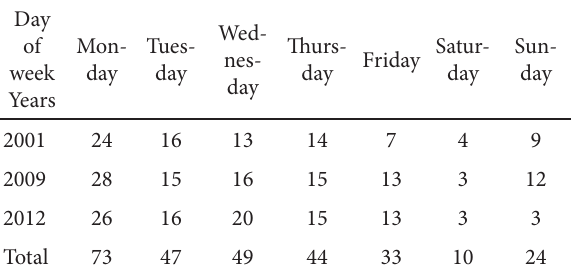
Table 3. Dependence of CVD leaps number exceeding the monthly average values by 10% on days of the week during maximum (2001, 2012) and minimum (2009) activity of the